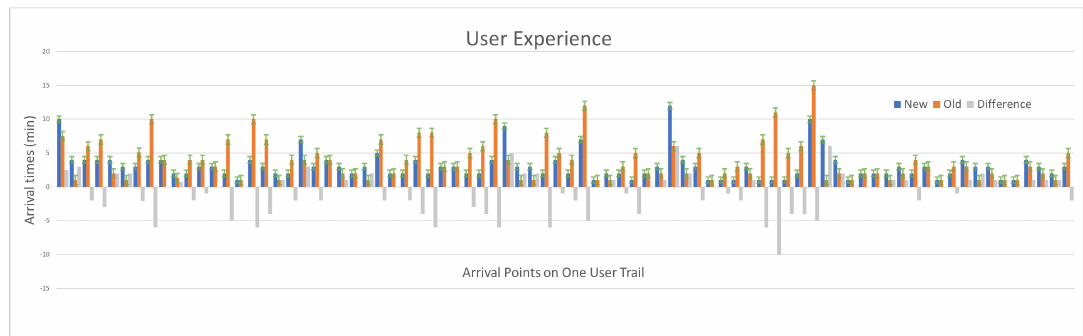
Figure 14. User Experience. Travel times with old (landmark-based) and new addresses in a treasure hunt. The generative addressing decreased the arrival time by